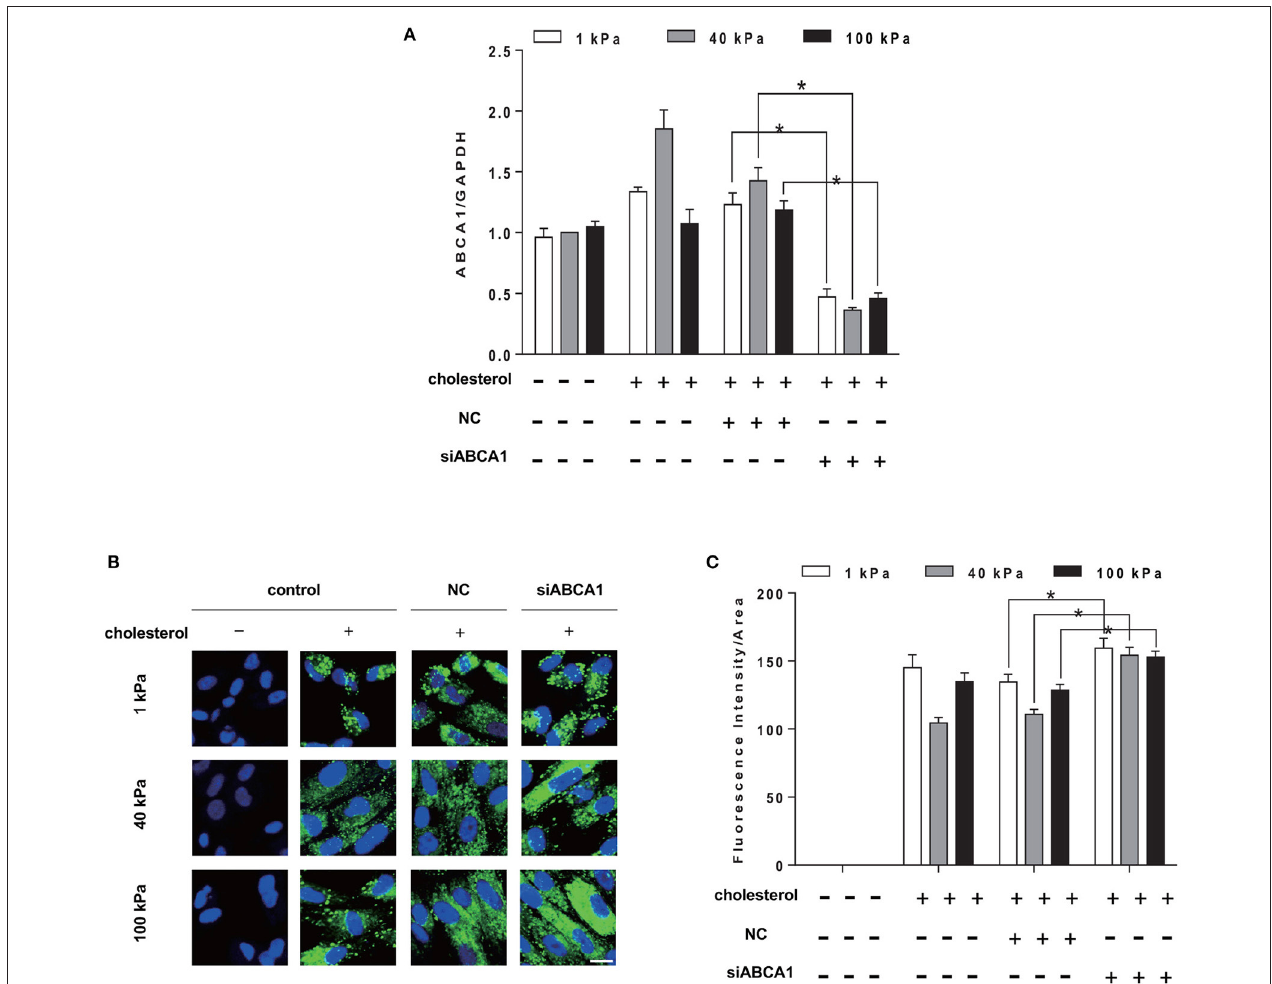
FIGURE 6 | Knockdown of ABCA1 promotes cholesterol accumulation in SMCs. SMCs were seeded on substrate with different stiffness and treated with 20 µ g/ml Chol: M β CD and siABCA1 for 72 h. (A) ABCA1 gene expression level was measured by RT-qPCR. GAPDH was used as the internal control for normalization ( n = 3) (NC, Negative siRNA control). (B) The cholesterol in SMCs after ABCA1 gene knockdown (green: BODIPY 493/503 staining of cholesterol; blue: DAPI staining of nucleus, scale bar = 10 µ m). (C) The level of cholesterol quantified by the fluorescence intensity and normalized by the area of the green fluorescence. ∗ p <